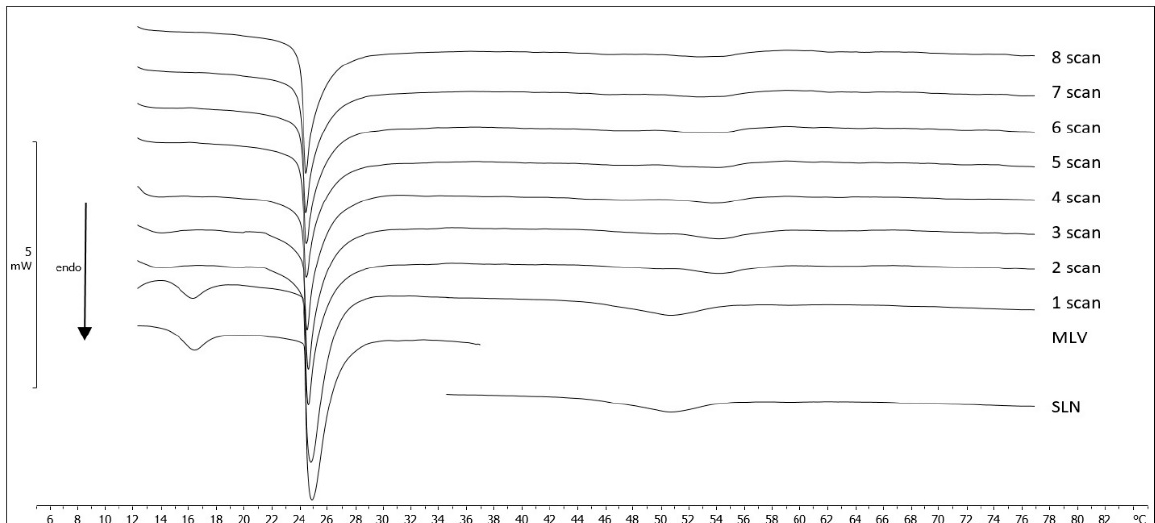
Figure 5. Calorimetric curves, in heating mode, of MLV put in contact with SLN, at increasing incubation time. There are 68 min between one scan and the next.